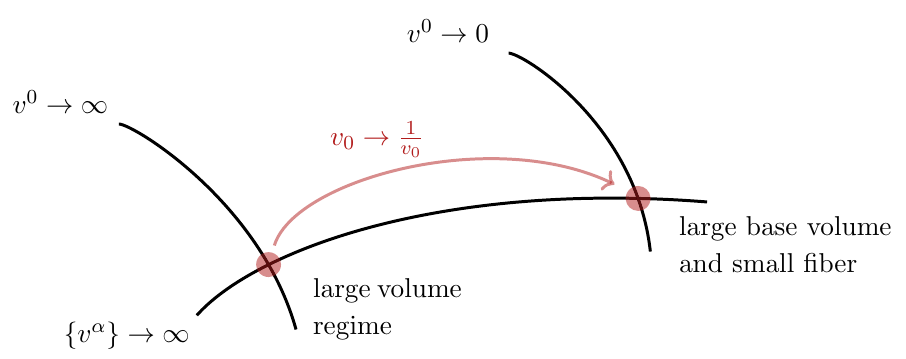
Figure 1 . The large volume regime is related to the small fiber regime by a double T-duality along the elliptic fiber. This duality is implemented by a Fourier-Mukai